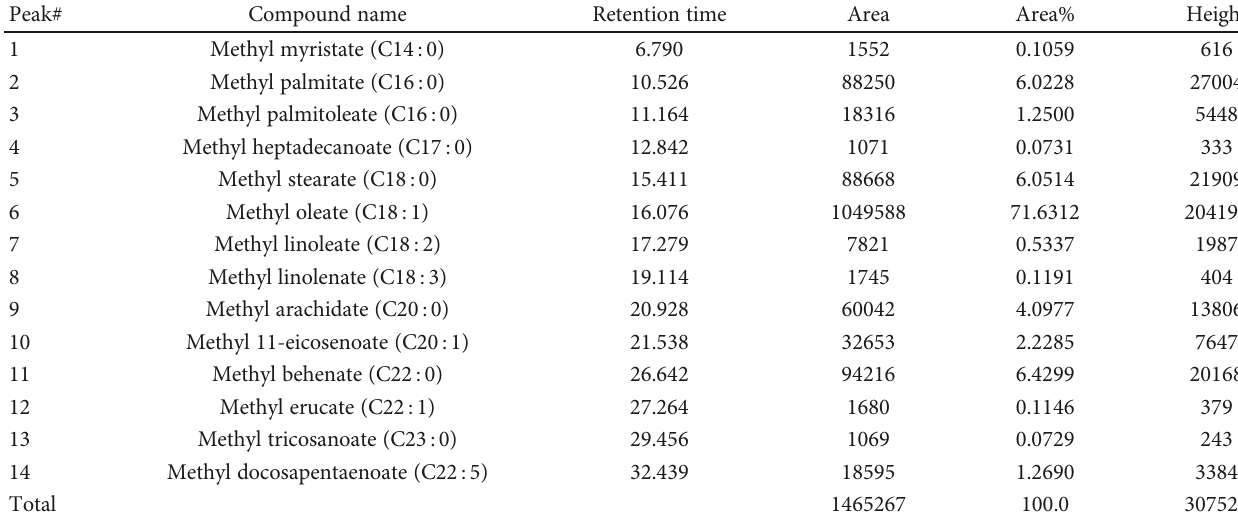
Table 1: Composition of the essential oil of the seed of M.